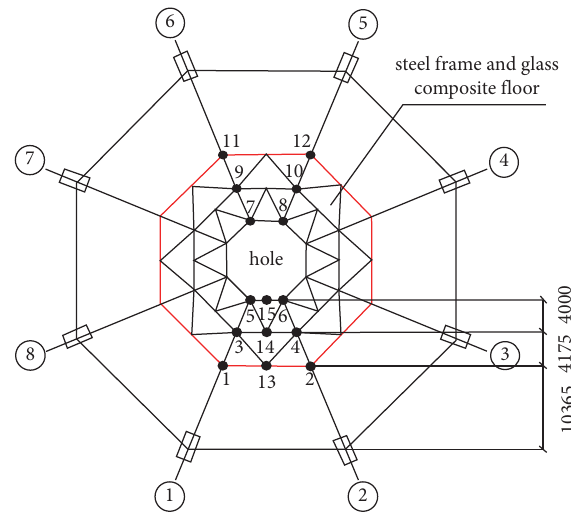
Figure 6: Layout of measuring points of the floor